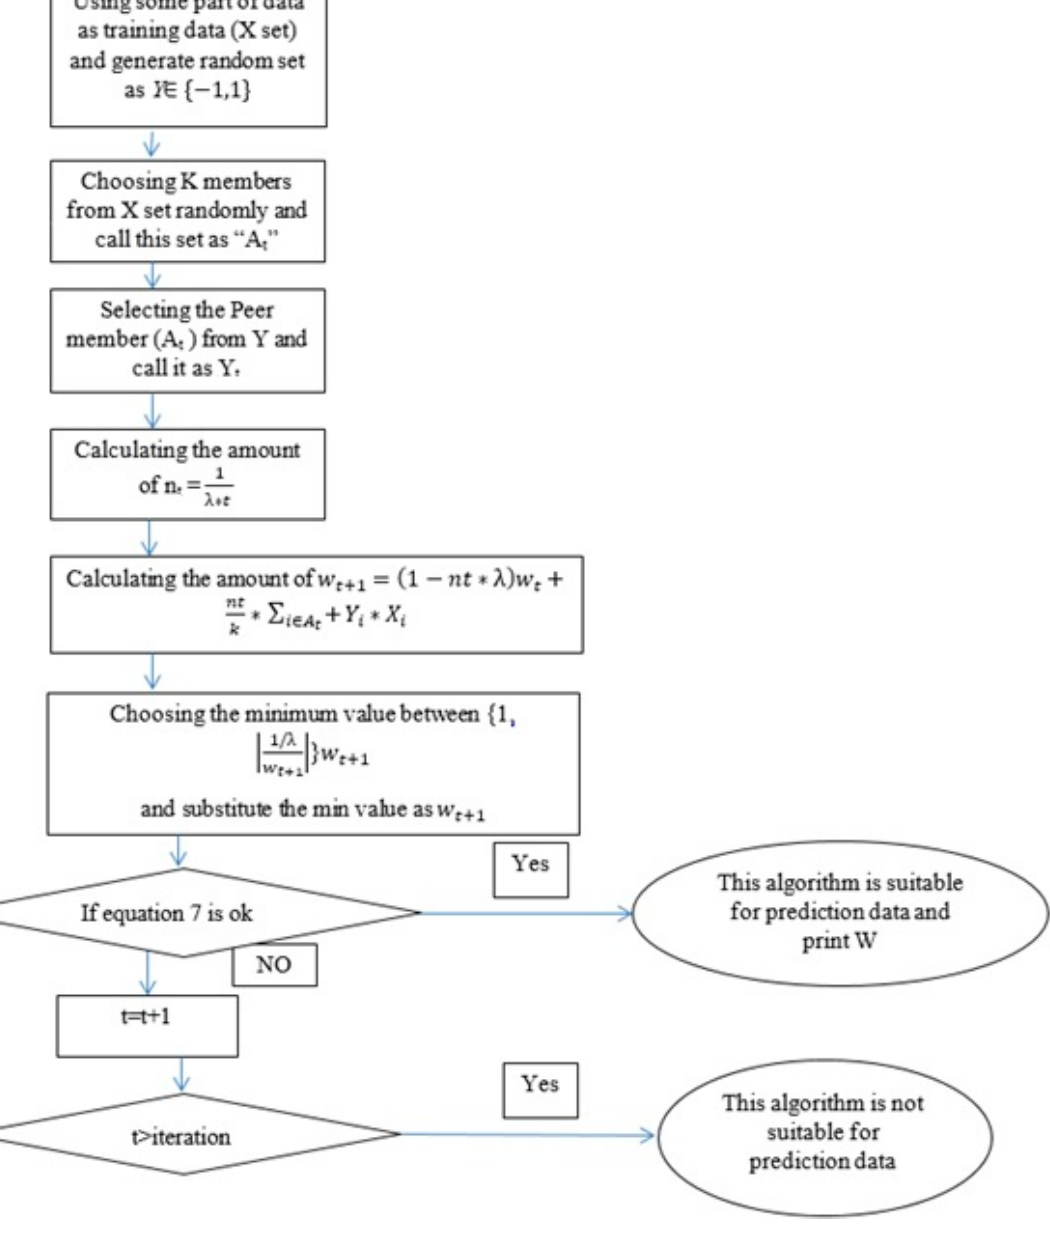
Figure 4. Pegasos step for solving prediction problem.